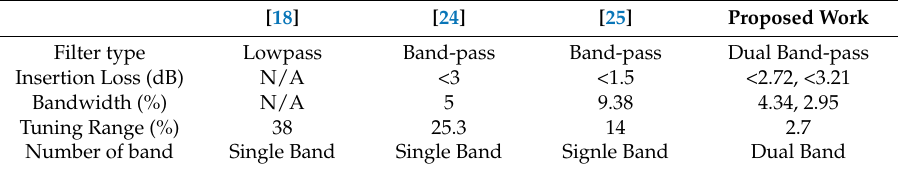
Table 2. Comparison table of the proposed filter performance with other liquid metal tunable filters.